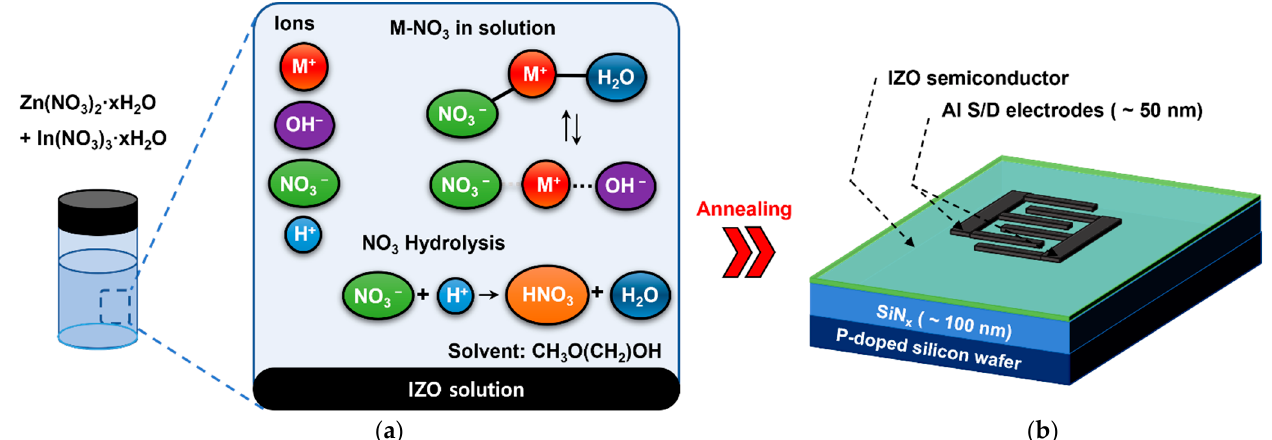
Figure 1. ( a ) IZO solution based on the metal–nitrate precursor used for manufacturing a -IZO TFT, and the types of ions and by-products that can be produced by dissolution. ( b ) Schematic illustration of finger-type solution process a -IZO TFT. Table 1. Molarity table of IZO solution for a -IZO TFT fabrication (the In molarity of solution is fixed). No. Zn01 Zn02 Zn03 Zn04 Zn05 Zn06 Zn07 Zn08 No. 0.1 0.15 0.2 0.25 0.3 0.4 0.5 0.6 Zn molarity (M) (failed) (failed) In molarity (M) 0.05 M (fixed)